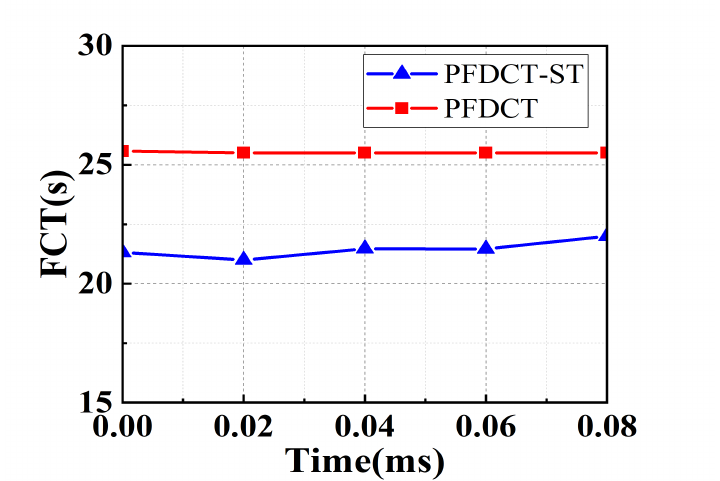
Figure 3. FCT comparison between PFDCT and PFDCT-ST.